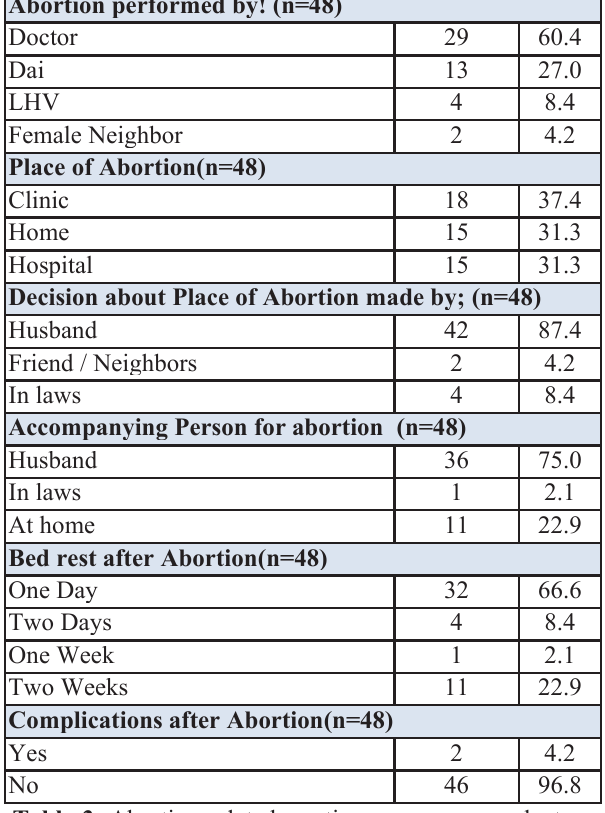
Table-3: Abortion-related practices among respondents